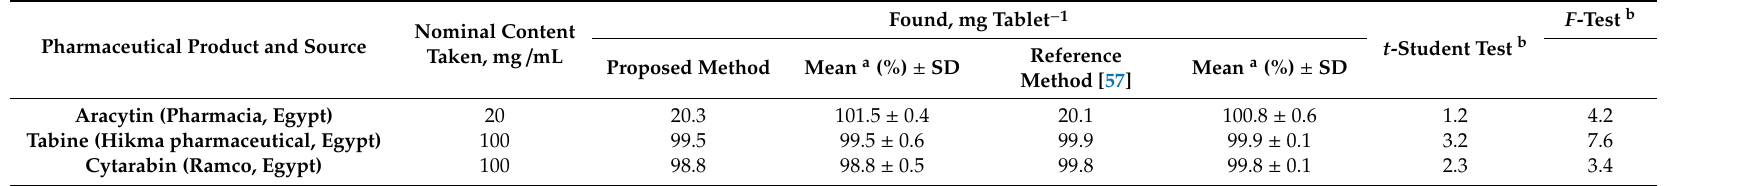
Table 3. Cytarabine assessment in di ff erent drug formulations using the cytarabine-membrane-based sensor.